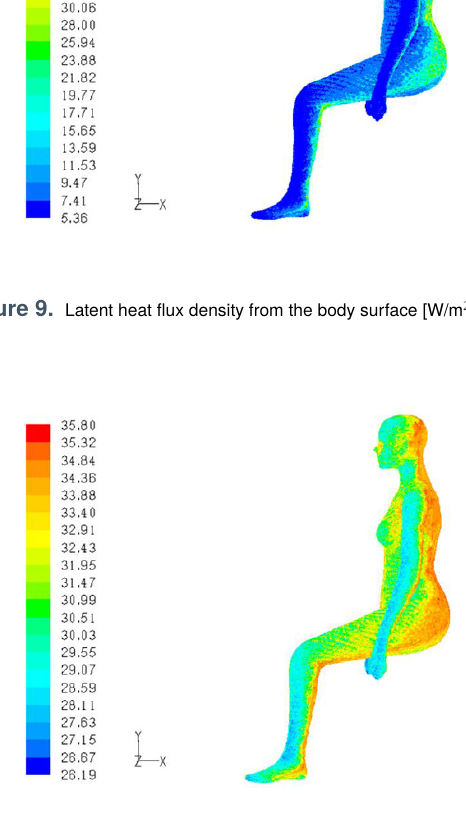
Figure 12. Skin wettedness